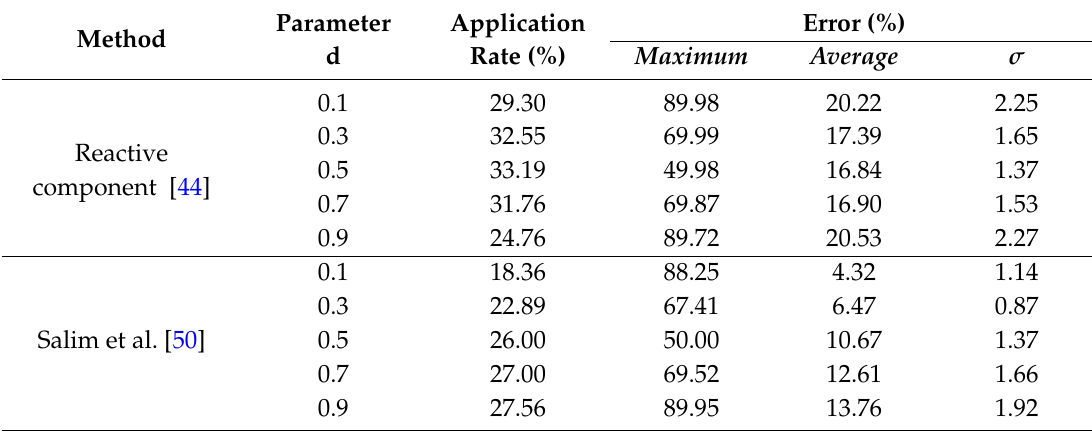
Table A3. Normalized position